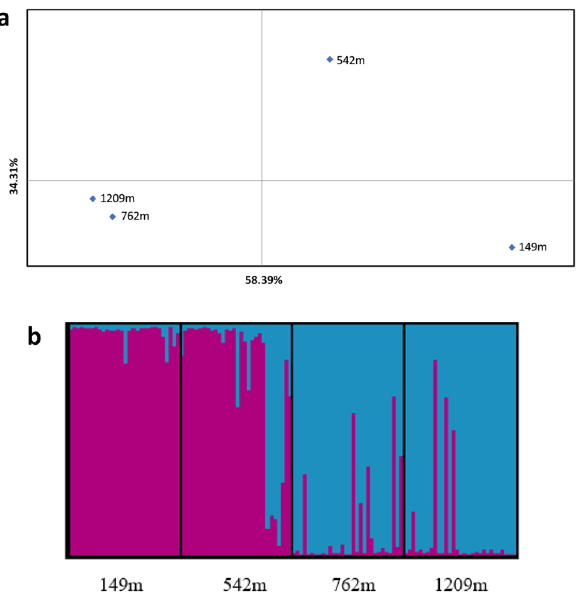
Figure 1. PCoA plot obtained from the F ST P matrix using GenAlEx ( a ) and graphical representation of the co-ancestry percentages obtained with Distruct 1.1. ( b ). In panel ( a ), highlighted populations are those showing a higher genetic correlation. In panel ( b ), each cluster is represented by a specific color and each bar represents a specific individual and its percentage of identity to the two clusters (K1 and